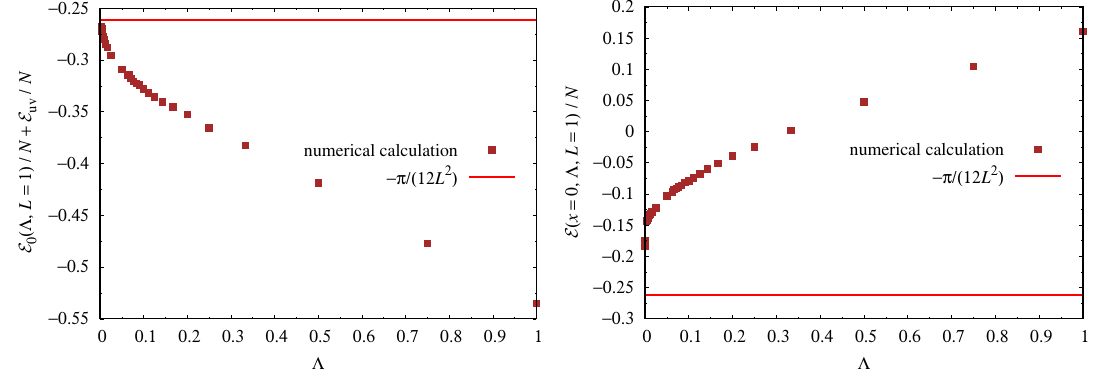
Figure 7 . The constant part of the energy den- sity, E 0 + E uv , is plotted as a function of (cid:3) for L = 1 (cid:12)xed.